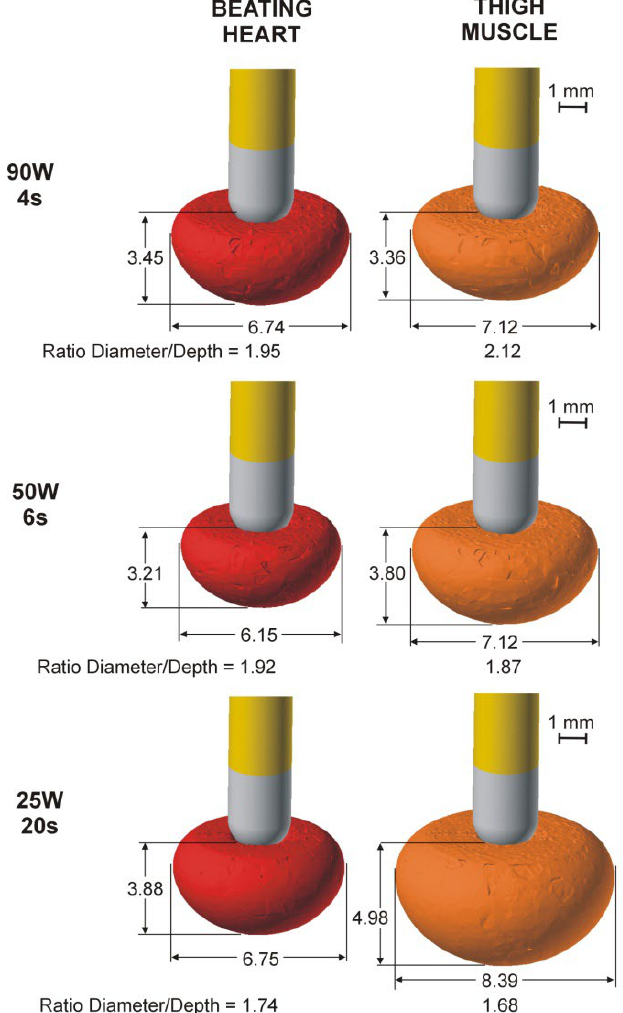
Figure 2. Lesion geometries (computed with Ω = 1 isoline after 90 s from the Arrhenius model) in the case of the perpendicular catheter for both models (beating heart and thigh muscle) and the three power settings (90 W/4 s, 50 W/6 s and 25 W/20 s).